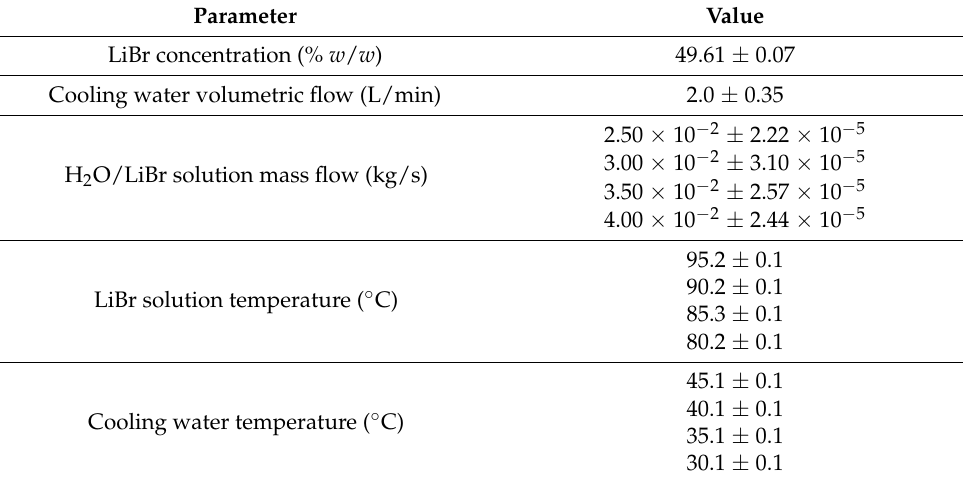
Table 4. Experimental operating